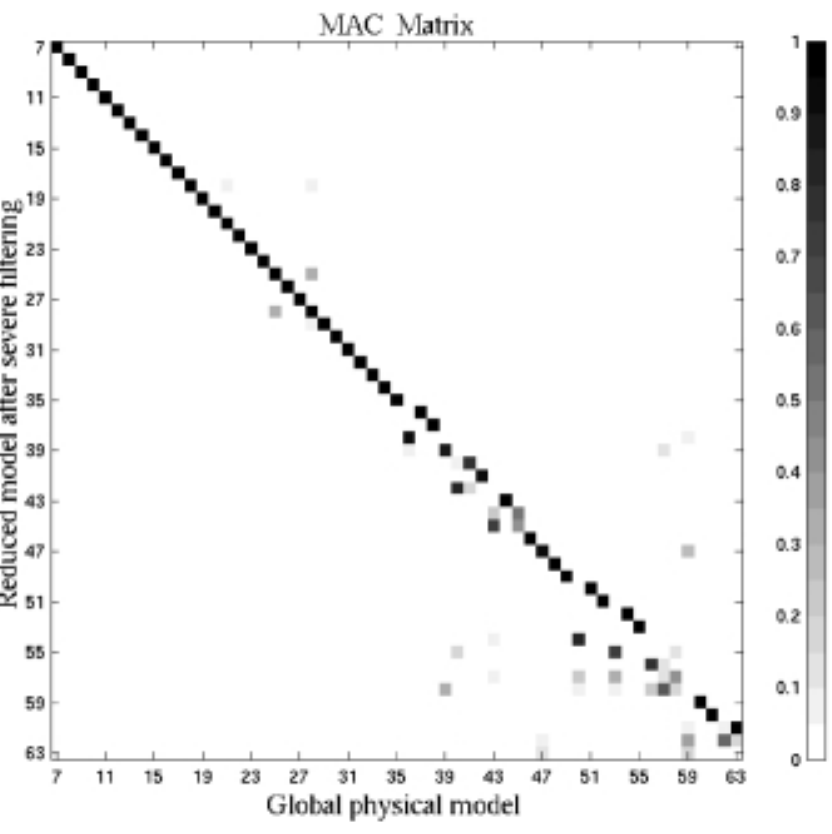
Fig. 11. MAC matrix after sever